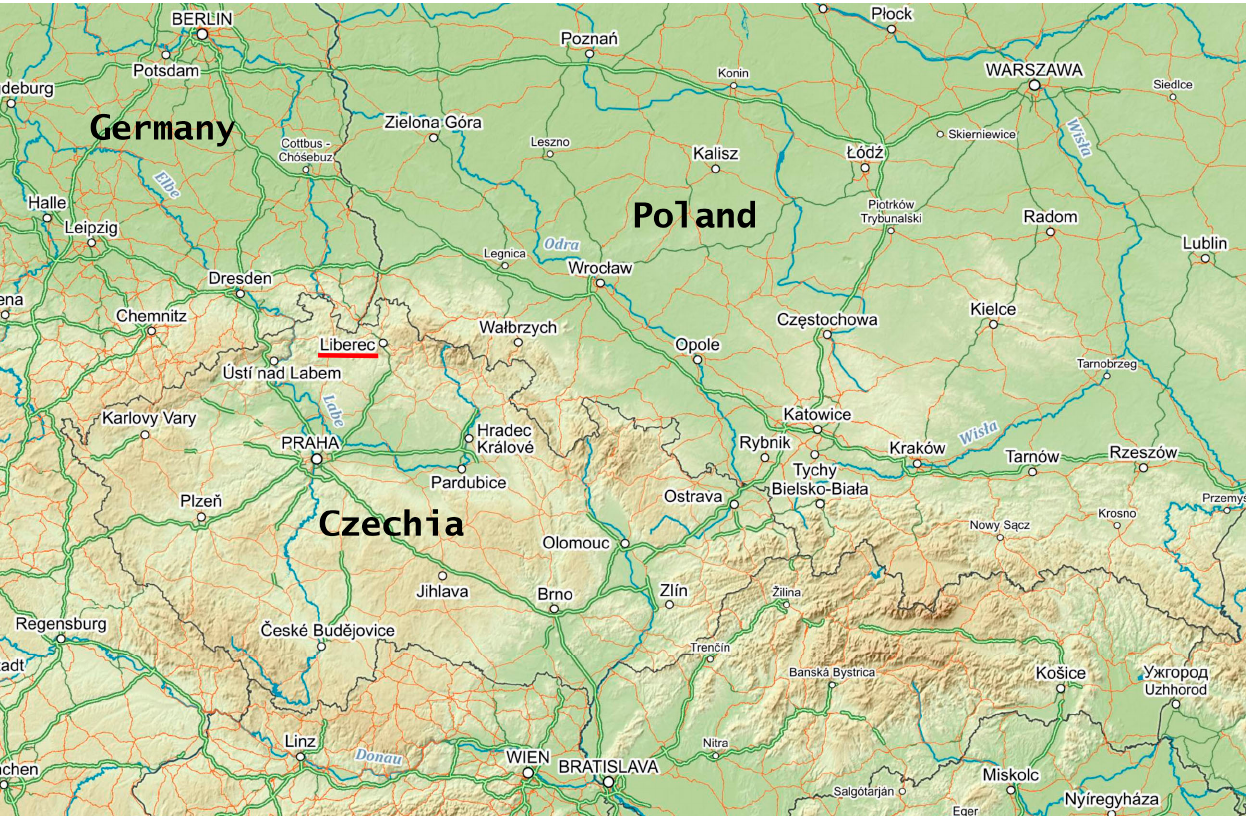
Figure 1. Location of Liberec on the map of Central Europe. Source map: mapy.cz (accessed on 30 March 2023).